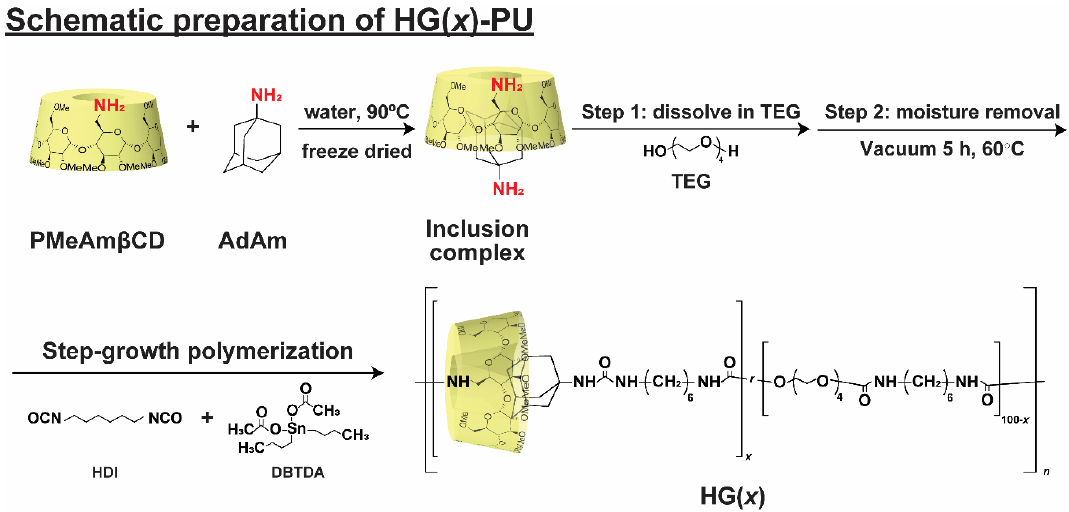
Figure 2. Schematic of the preparation of HG( x ). The “ x ” in HG( x ) is the mol% of the PMeAm β CD and AdAm units.